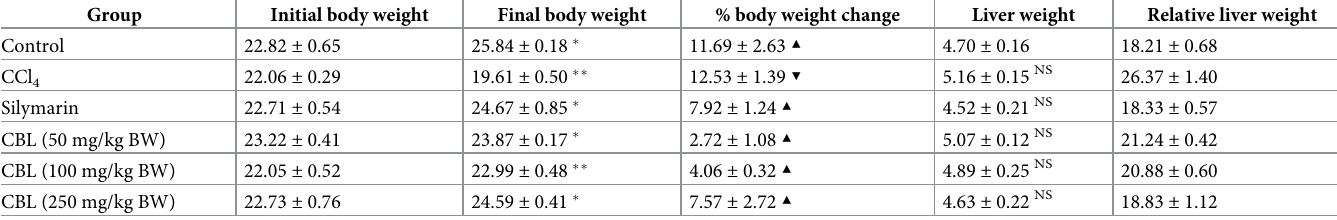
Final body weight was compared with initial body weight of corresponding group and liver weight of treated groups was compared with liver weight of control group. ▲ represents increase and ▼ represents